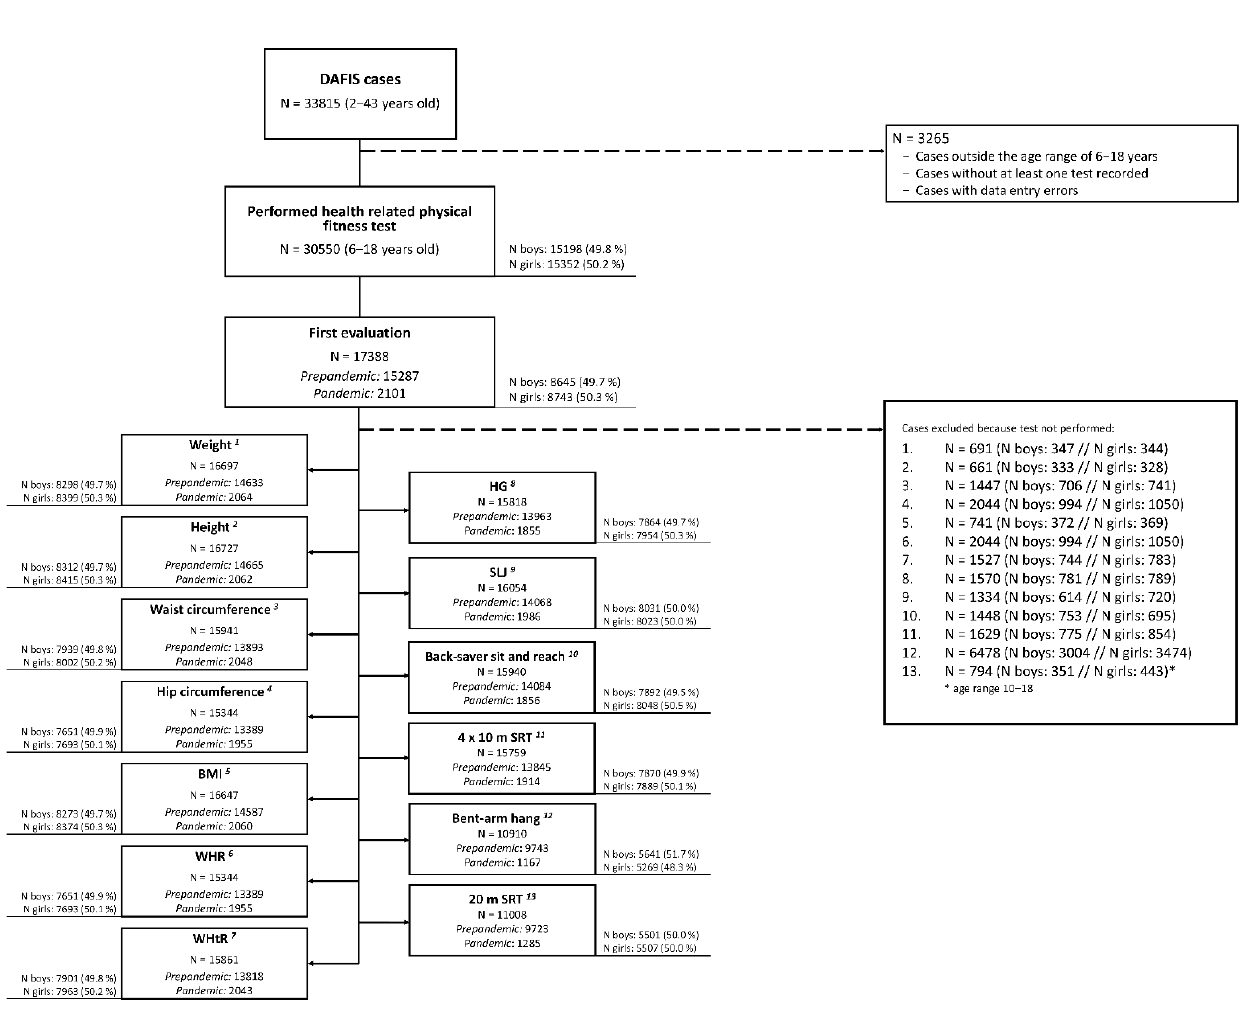
Figure 1. Flowchart of the exclusion criteria. BMI: body mass index; WHR: waist to hip ratio; WHtR: waist to height ratio; HG: handgrip; SLJ: standing long jump; 4 × 10 m SRT: 4 × 10 m shuttle run test; 20 m SRT: 20 m shuttle run test.